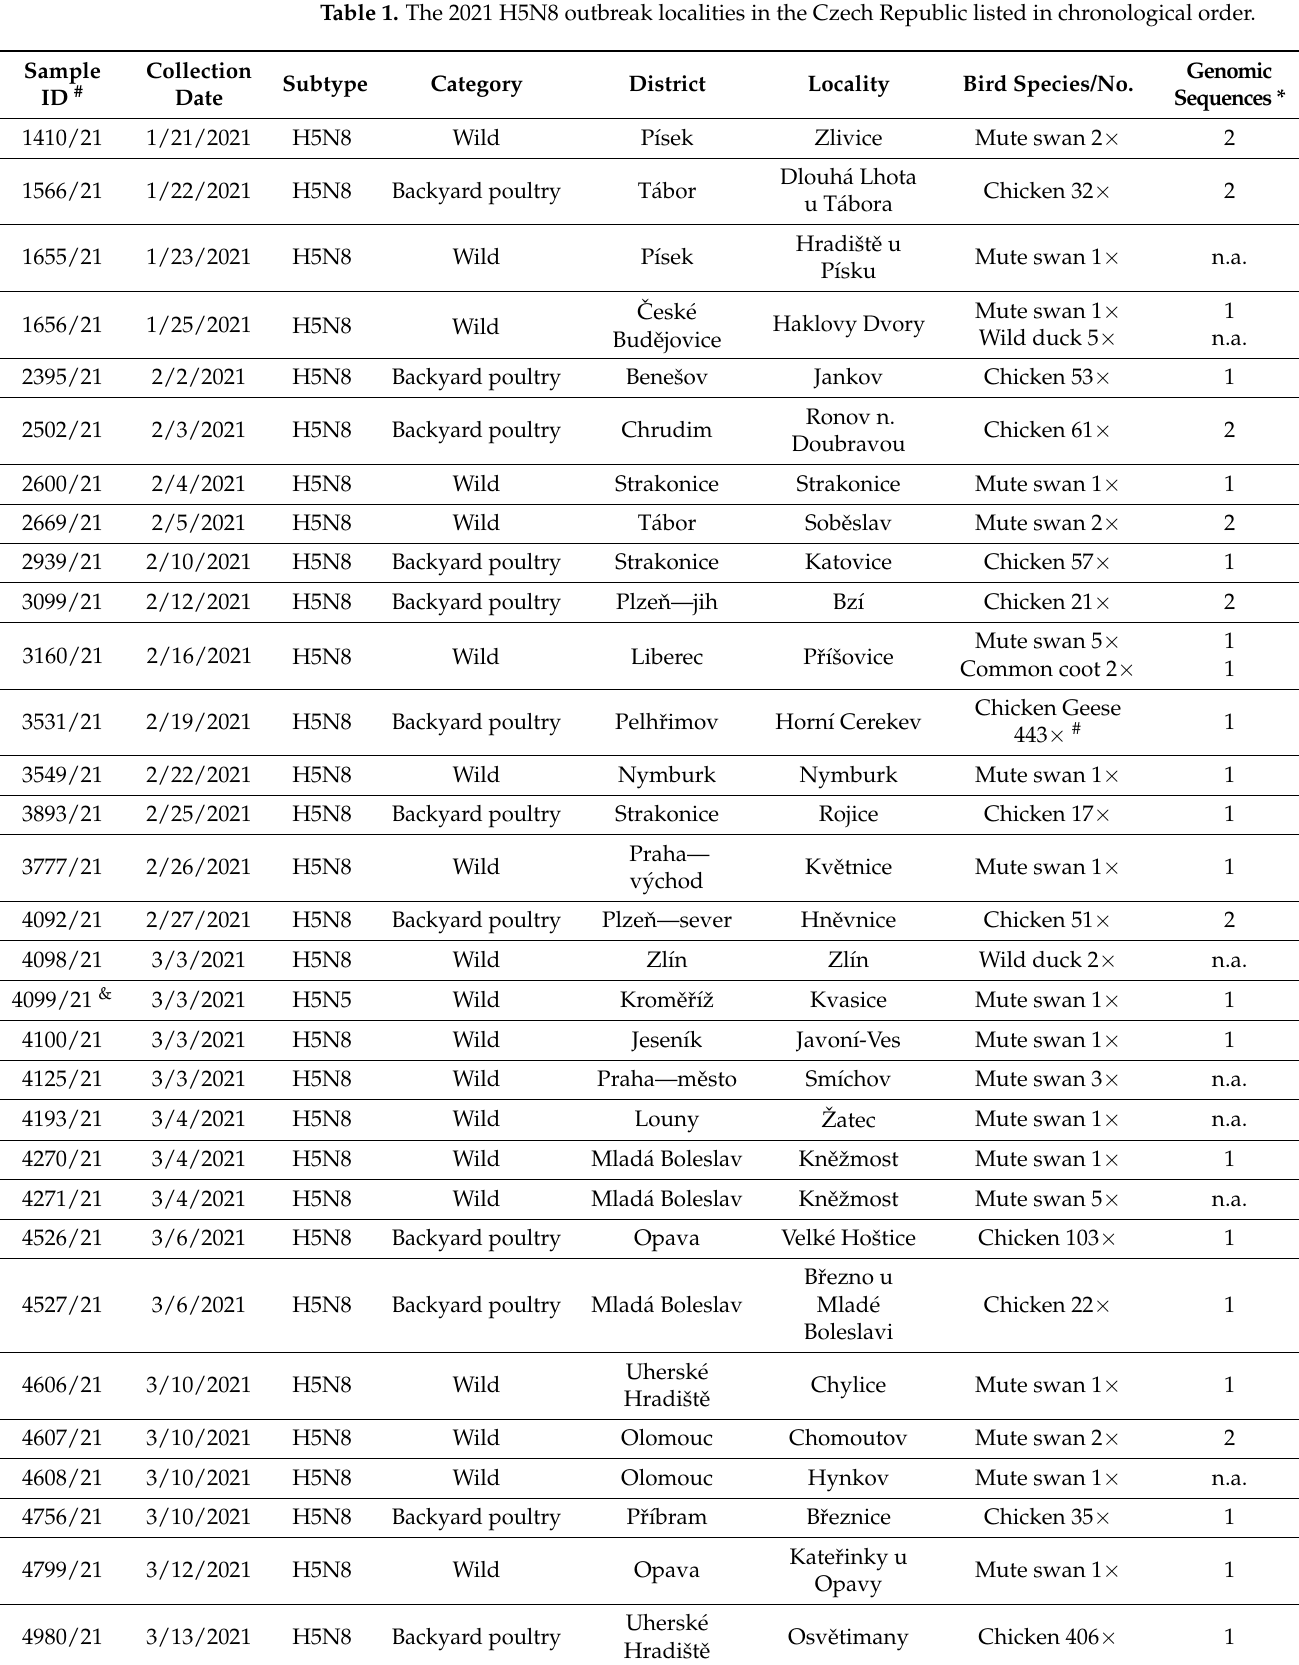
Table 1. The 2021 H5N8 outbreak localities in the Czech Republic listed in chronological